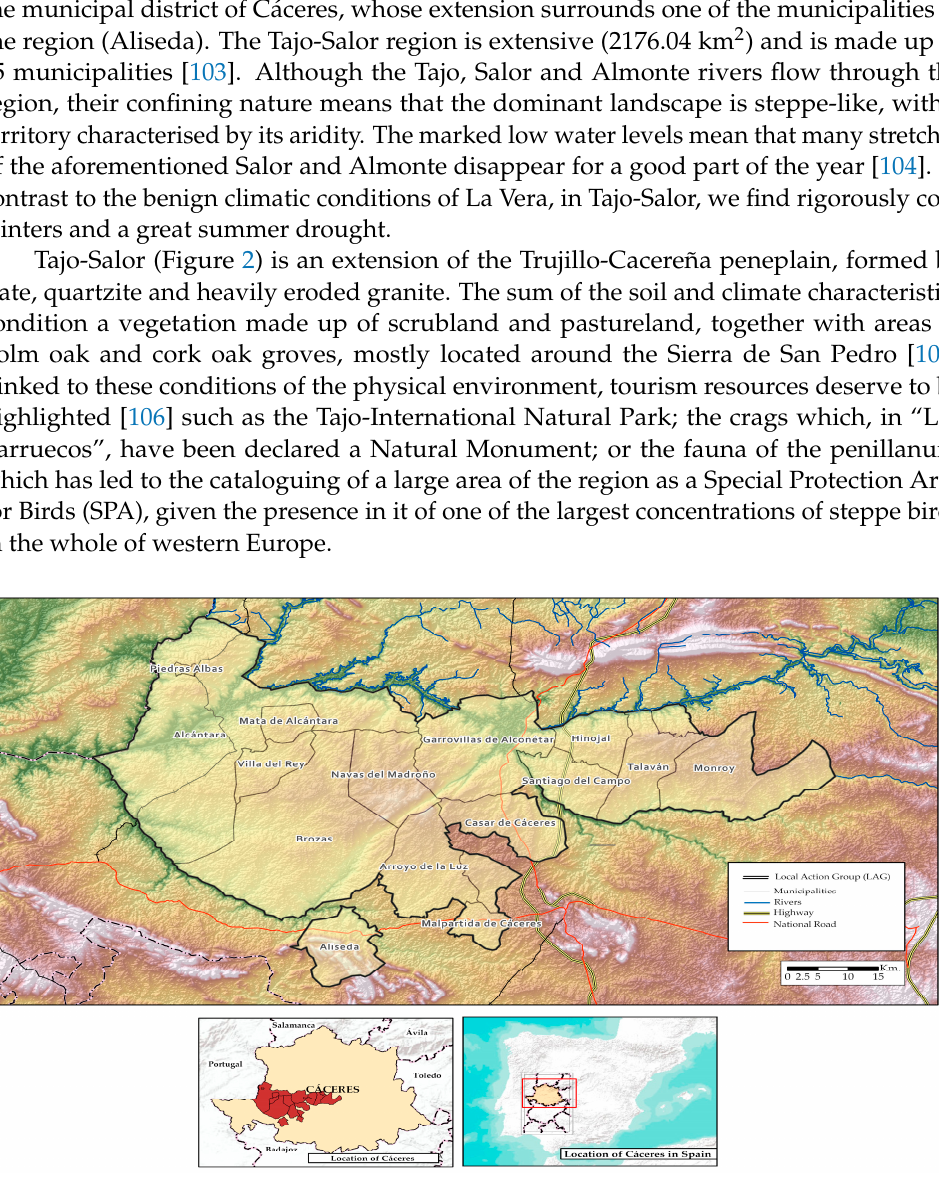
Figure 2. Location of the Tajo-Salor region, Source: Own elaboration.